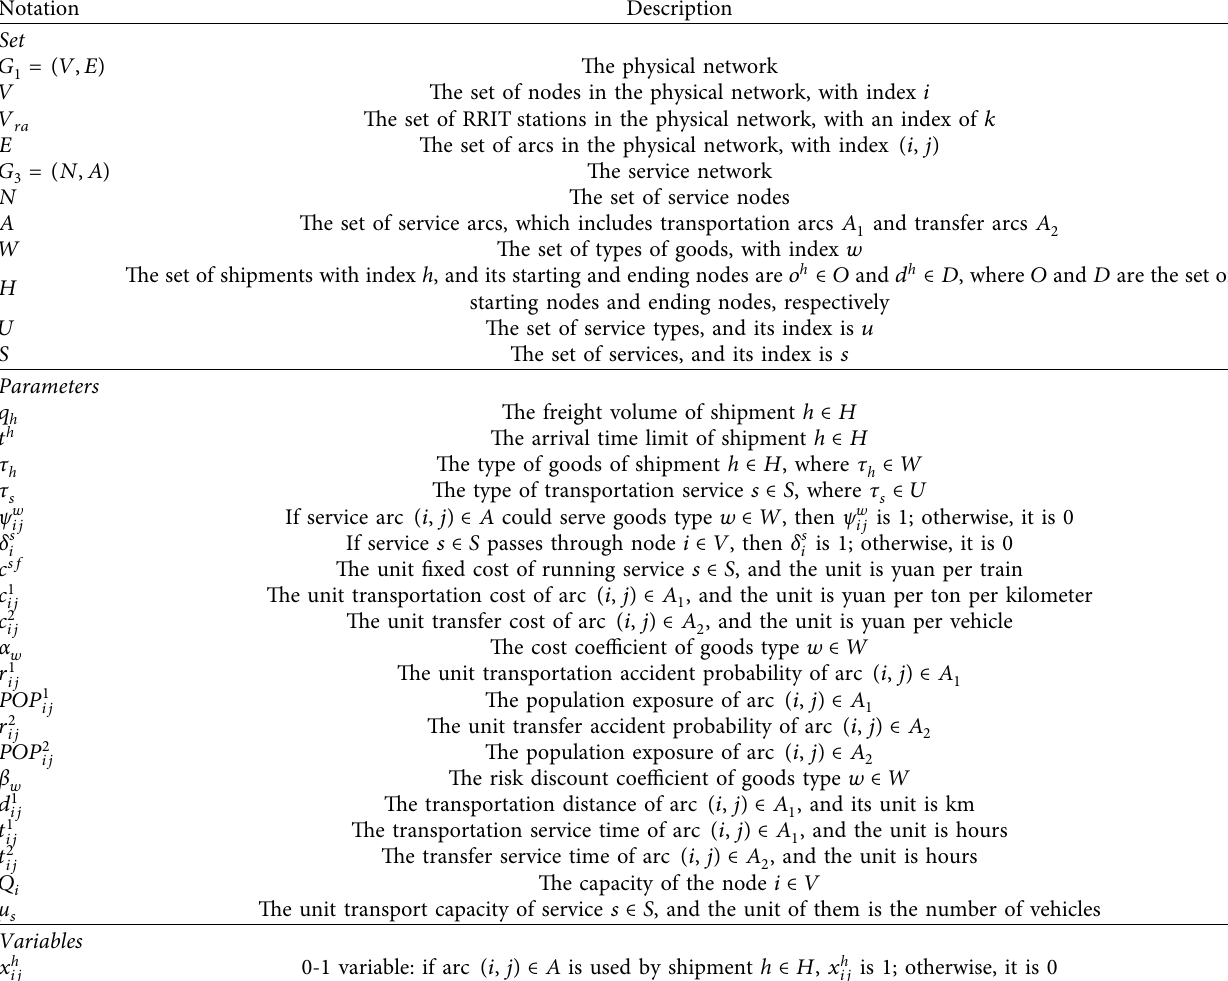
Table 2: Definitions of other